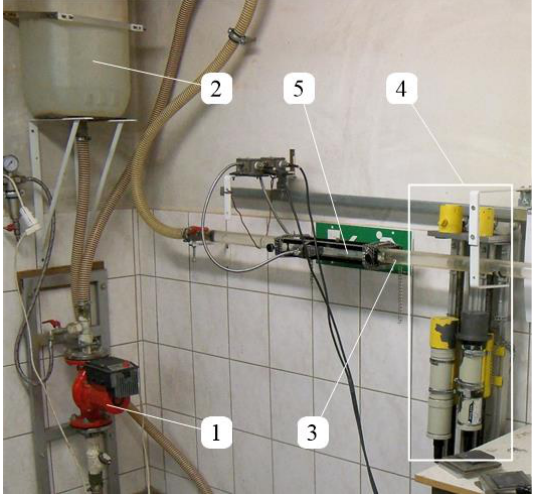
Fig. 1. Fragment of laboratory stand for the measurement of two-phase liquid-gas flow: 1 – pump, 2 - expansion tank, 3 – pipeline, 4 – gamma absorption measurement system, 5 – ultrasonic